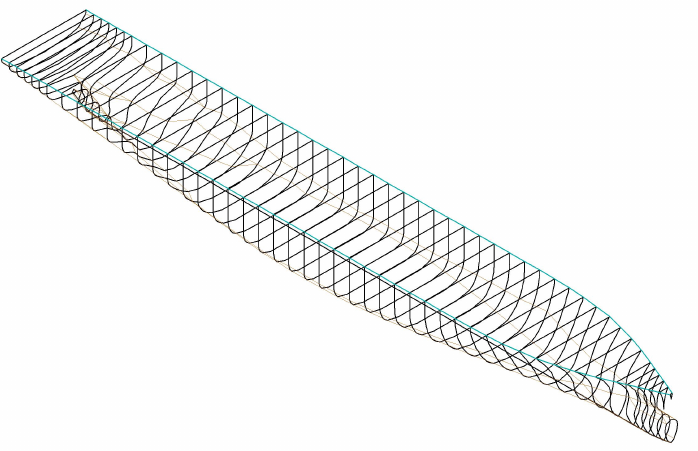
Figure 21. Isometric view of the KCS container ship geometry in section-based GF format. Blue lines mark the deck edge. See Section 6 for a link to download this geometry